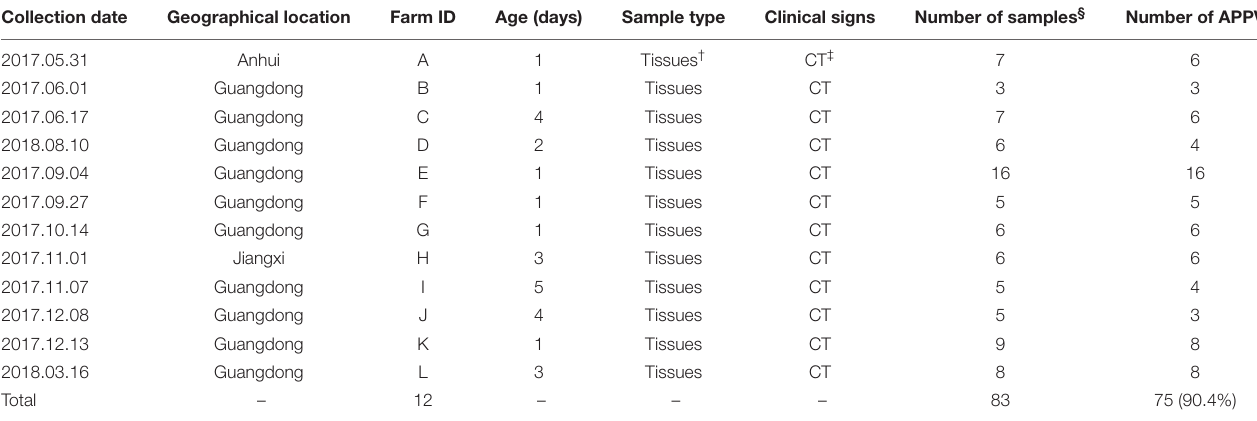
TABLE 1 | Clinical samples collected between 2017 and 2018 in Southern China and results of APPV detection using RT-PCR.